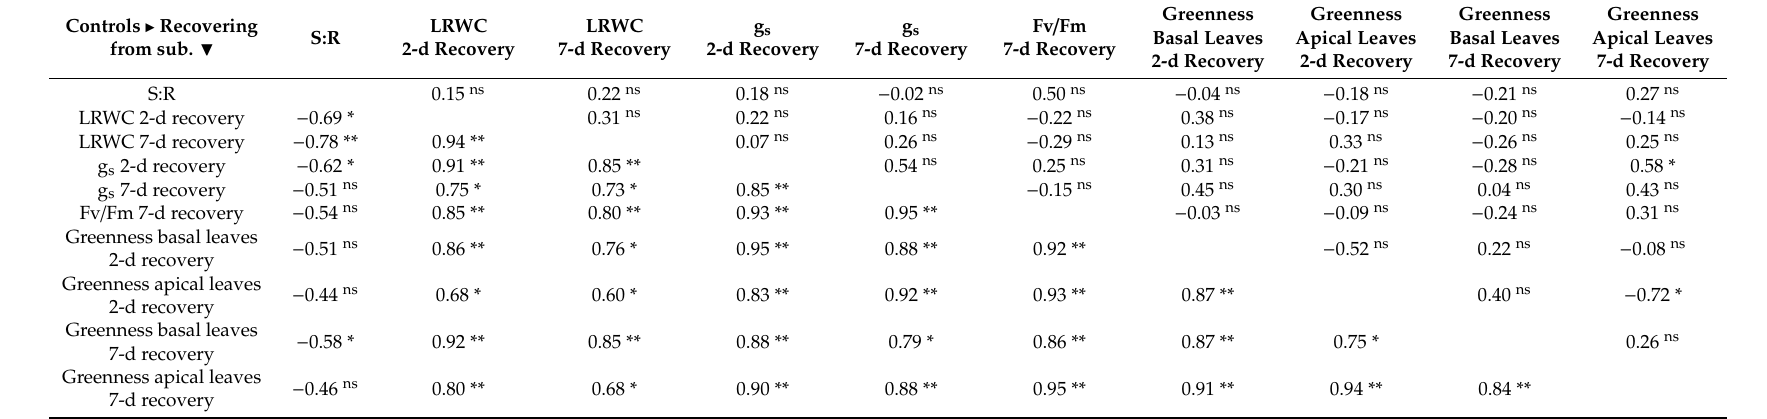
Table 1. Pearson correlation coefficients for the morphophysiological traits measured over the recovery phase on 12 genotypes of Lotus japonicus (10 recombinant inbred lines and their parents Gifu and MG20) subjected to control (above the diagonal) for three weeks or complete submergence conditions for one week (below the diagonal) and allowed to grow for another 2 weeks. Only correlations for morphophysiological traits that were significantly related to RGR during the recovery from submergence are shown (data from Figures 3–7). Abbreviations are S:R (shoot to root dry mass ratio at de-submergence), LRWC (leaf relative water content), g s (stomatal conductance), Fv/Fm (chlorophyll fluorescence of dark-adapted leaves). Significant differences: *, p < 0.05; **, p < 0.001; ns, p > 0.05. Controls